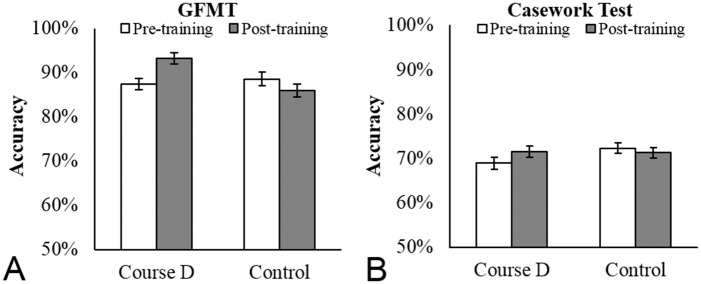
Identification accuracy of Course D trainees before and after training.Accuracy on the GFMT (A) and casework test (B) at pre- and post-training for 32 Course D trainees from a UK police service and 20 control participants. Course D trainees showed significant improvement on the GFMT but not the casework test. Error bars show within-subjects corrected standard error of the mean [21].